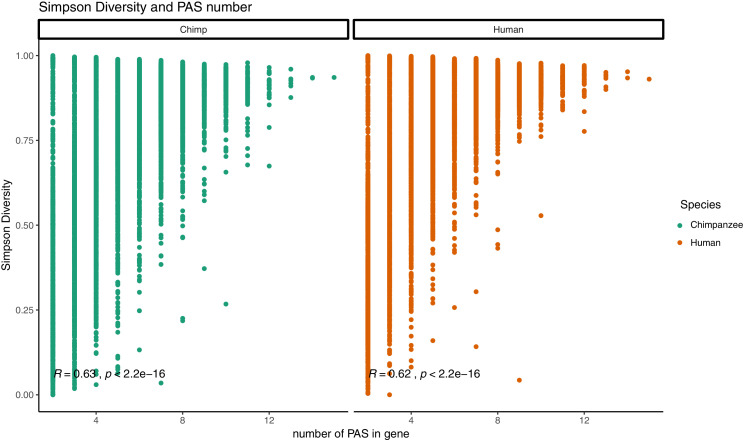
Relationship between Simpson diversity index and polyadenylation sites (PAS) number.Simpson diversity index plotted against the number of PAS detect for each gene. Pearson’s correlation and significance in black.